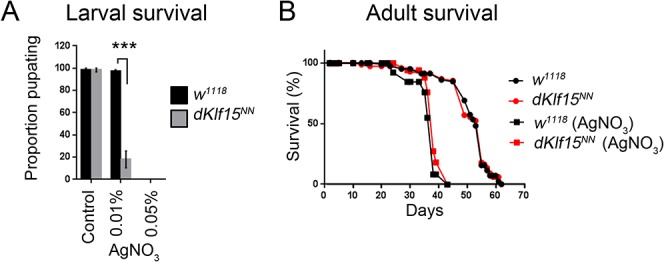
Survival of dKlf15 mutants.(A) Survival of larvae on yeast containing different amounts of silver nitrate (AgNO3); ***P<0.001; n = 3 independent trials starting with 20 eggs per trial. (B) Survival of adult males on control (circles) or AgNO3 diet (squares); n = 85–120 flies per genotype (housed as 15 flies per vial). Genotype had no effect on lifespan or survival on diet containing silver nitrate (P>0.05). Silver nitrate was toxic to both genotypes (P<0.001, relative to flies on the control diet).